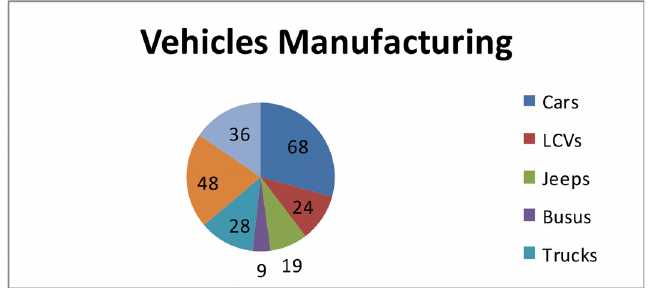
Figure 2. Number of respondents according to vehicle manufacturing